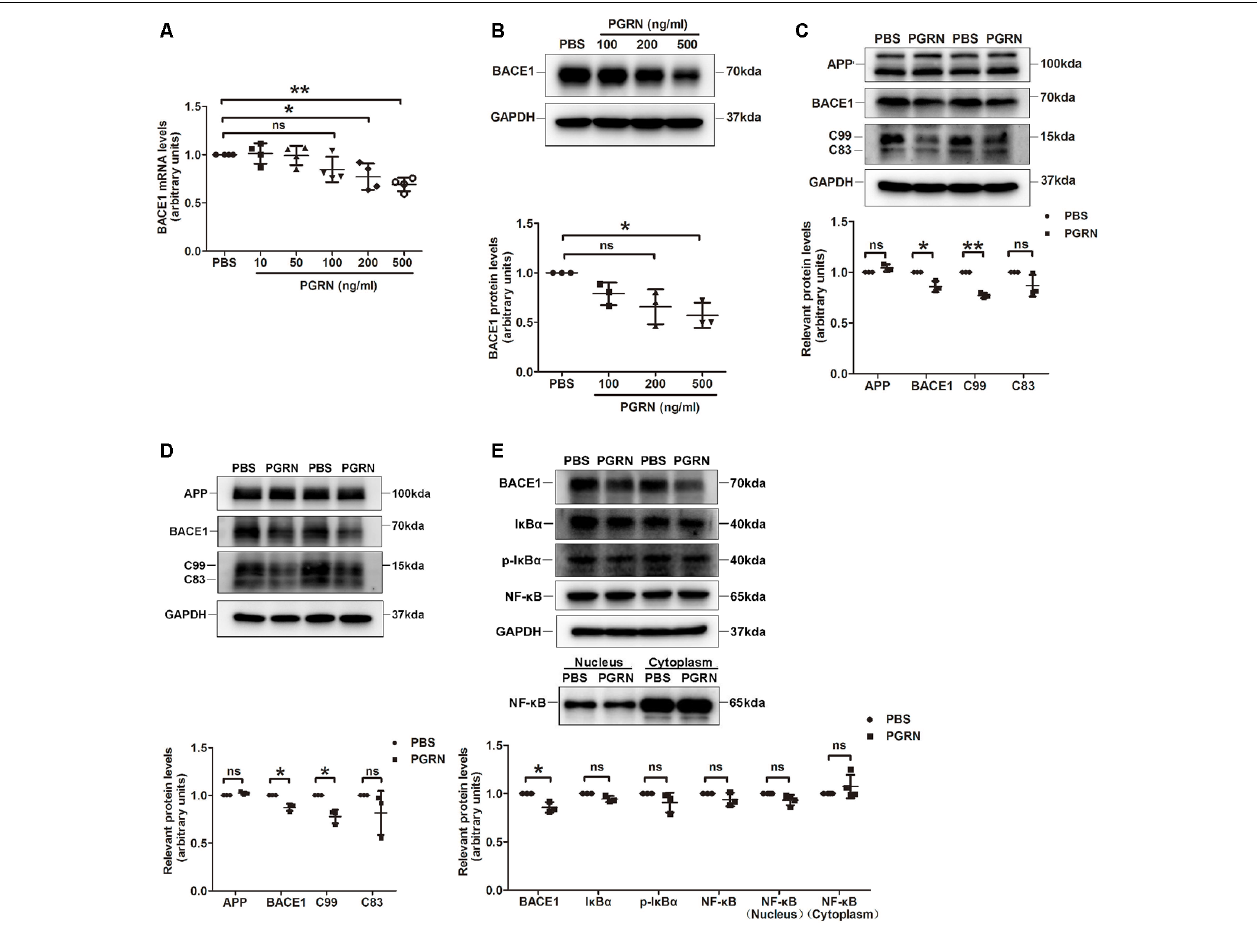
FIGURE 3 | PGRN treatment inhibits BACE1 expression. (A) BACE1 expression was determined by qRT-PCR in N2a cells after treated with different concentration PGRN, all values were normalized to the group treated with PBS for each experiment. Data were from four independent experiments, * p < 0.05, ** p < 0.01, paired student’s t -test. (B) Levels of BACE1 in N2a cells treated with different concentration PGRN were determined by western blot, all values were normalized to the group treated with PBS for each experiment. n = 3 independent experiments, * p < 0.05, paired student’s t -test. (C) Levels of amyloid precursor protein (APP), BACE1, C99 and C83 in N2a cells treated with 500 ng/ml PGRN were determined by western blot, all values were normalized to the group treated with PBS levels for each experiment. Data were from three independent experiments, * p < 0.05, ** p < 0.01, paired student’s t -test. (D) Protein levels of amyloid precursor protein (APP), BACE1, C99 and C83 in primary culture neurons treated with 500 ng/ml PGRN were determined by western blot, all values were normalized to the group treated with PBS levels for each experiment. Data are from three independent experiments, * p < 0.05, paired student’s t -test. (E) Protein levels of BACE1, I κ B, p-I κ B, and NF- κ B in N2a cells treated with 500 ng/ml PGRN were determined by western blot. All values were normalized to the group treated with PBS levels for each experiment. Data were from three independent experiments, * p < 0.05, paired student’s t -test. ns, not